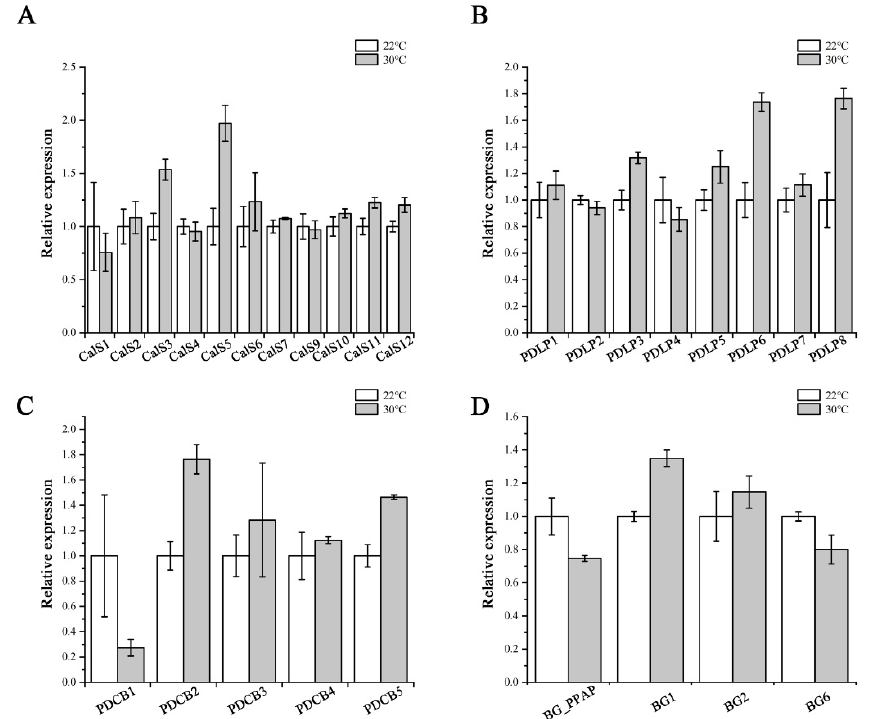
Figure 7. Expression of callose-associated genes after heat stress treatment. Quantitative RT-PCR analysis of CalSs ( A ), PDLPs ( B ), PDCBs ( C ), and BGs ( D ) transcript levels in root tips of Col-0 after 24 h heat stress treatment. Total RNA was isolated from root tips. eIF-4A was used as an internal control. Three independent experiments were performed. Data are means ± SE of three biological repetitions, n =